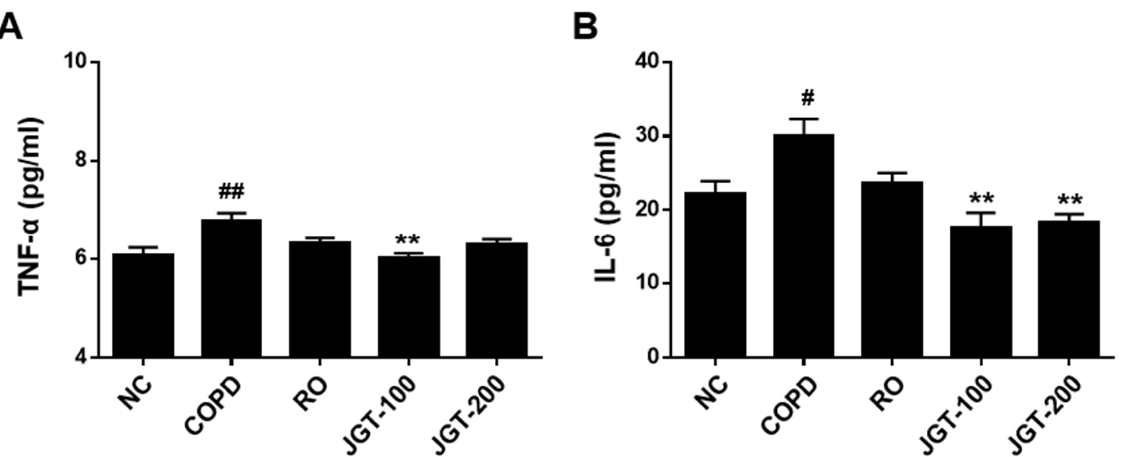
Figure 5. Effects of JGT on proinflammatory cytokine concentrations. ( A ) TNF-α and ( B ) IL-6 in BALF, as detected by ELISA. NC, normal control mice; COPD, CS & LPS-treated mice; RO, roflumilast (5 mg/kg) along with CS & LPS-treated mice; JGT-100, JGT (100 mg/kg) along with CS & LPS-treated mice; JGT-200, JGT (200 mg/kg) along with CS & LPS-treated mice. Data are displayed as means ± SEM. # p < 0.05 and ## p < 0.01 compared with NC; ** p < 0.01 compared with COPD.